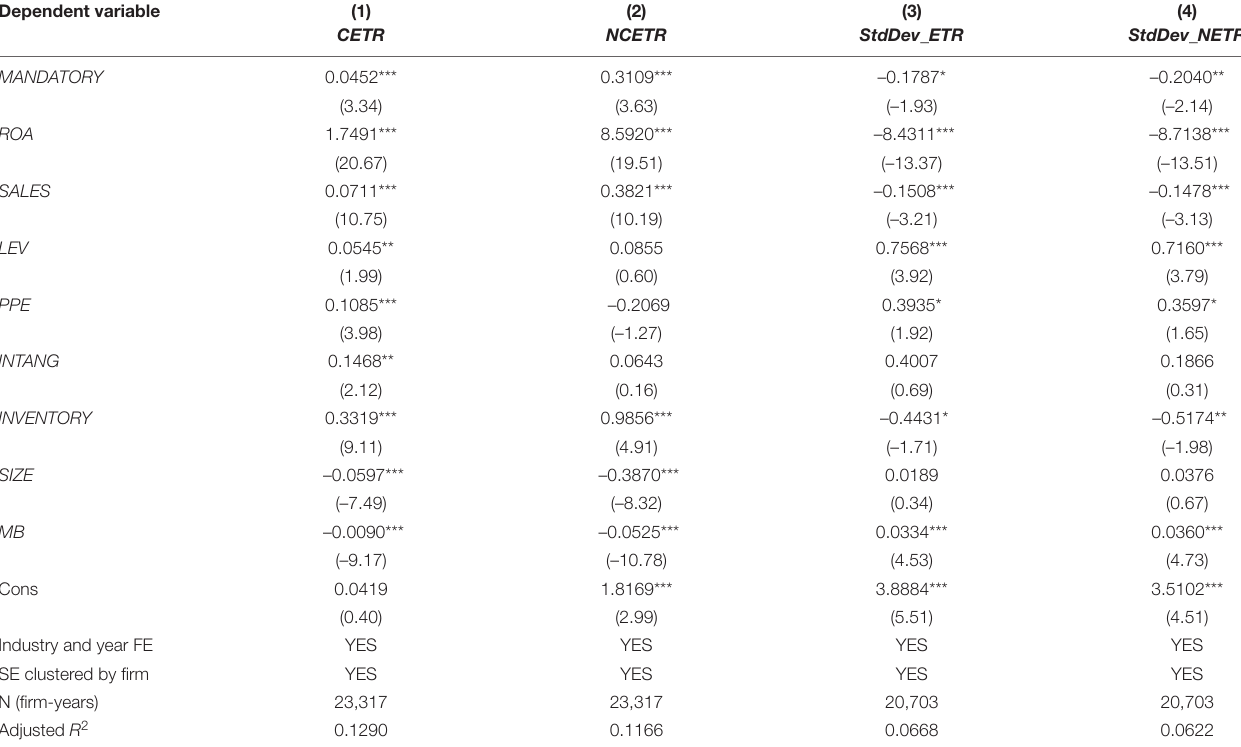
TABLE 4 | Robustness